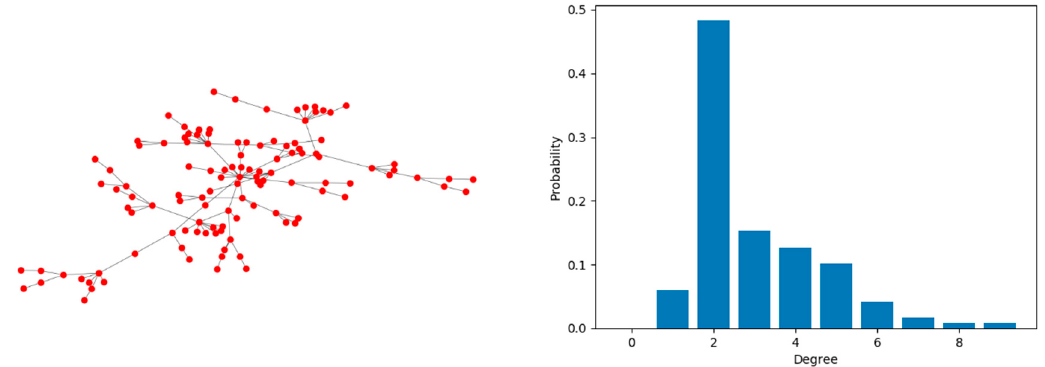
Figure 5. The power grid and its degree distribution.